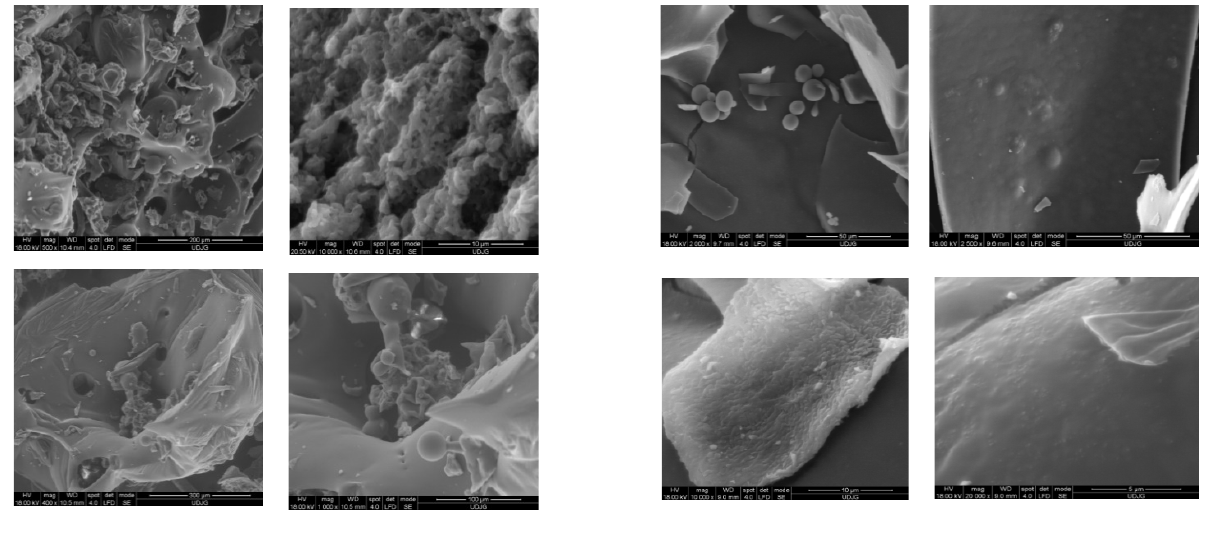
Figure 3. Structure of the powders obtained by Ziziphus mauritiana ( a ) and Balanites aegyptiaca ( b ) extracts microencapsulation.